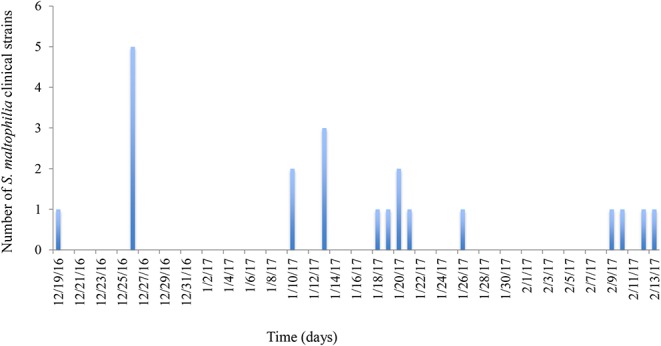
Graphical representation of the epidemiology of outbreak-associated S. maltophilia strains over time. The frequencies of clinical strains were determined by their persistence time during the outbreak. The first strain was identified on December 19th, 2016, and the last strain was identified on February 13th, 2017. The culture of environmental S. maltophilia strains was performed on December 26, 2016.